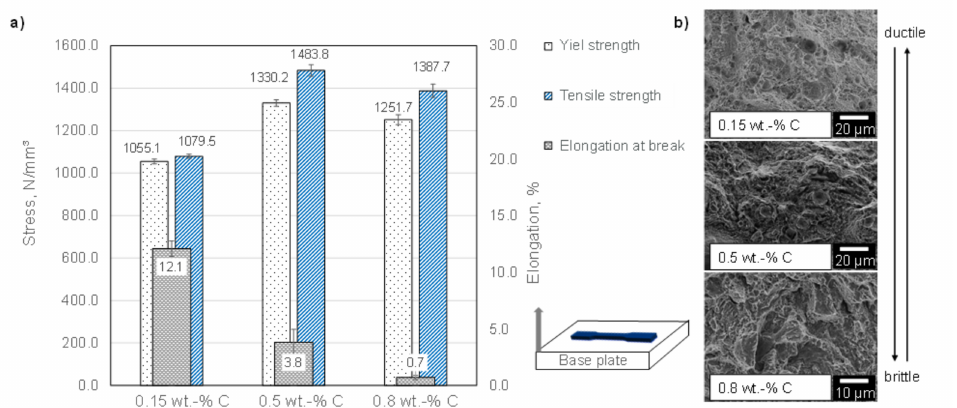
Figure 9. ( a ) Results of the tensile tests showing the strength-ductility trade-off with a varied carbon content; the arrow indicates the build direction ( b ) Fracture surfaces of the corresponding specimen changing from ductile to brittle behaviour with an increased carbon